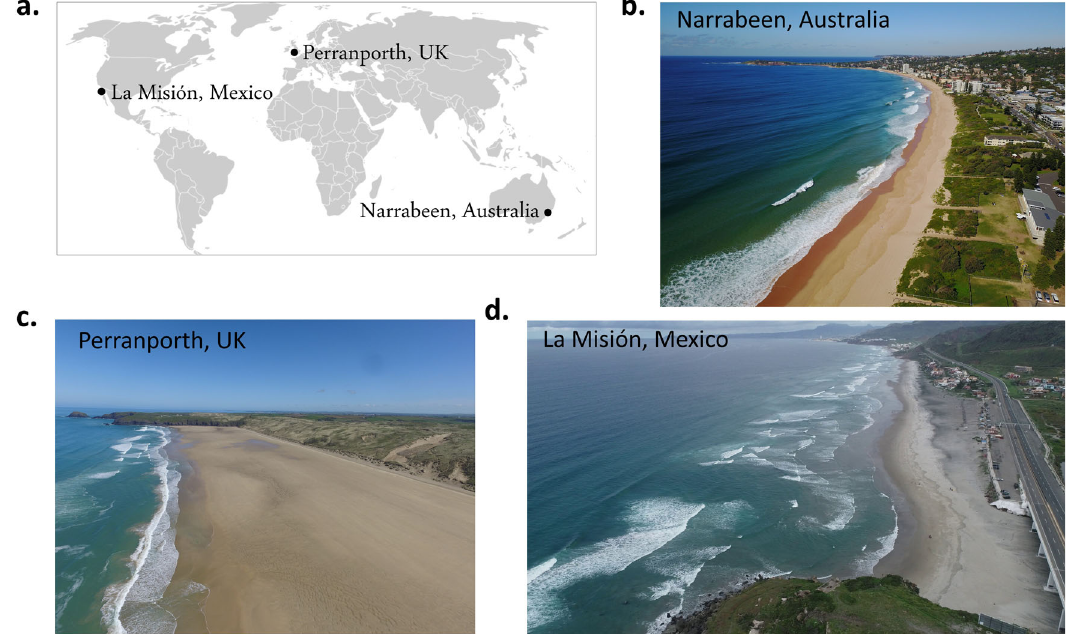
Fig. 2 Location and representative photos of the three study sites spanning three continents. a Global map indicating the location of the three study sites. Representative UAV images of the three sites are indicated for ( b ). Narrabeen, Australia (photo: Mitchell Harley); c Perranporth, UK (photo: Tim Scott); and d La Mision, Mexico (photo: Amaia Ruiz de Alegría-Arzaburu).